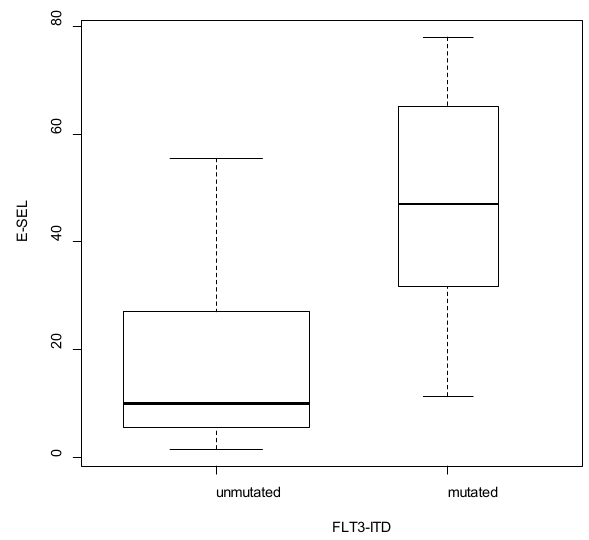
Fig. 1. The association of FLT3-ITD mutation and E-selectin, P = 0.0010.